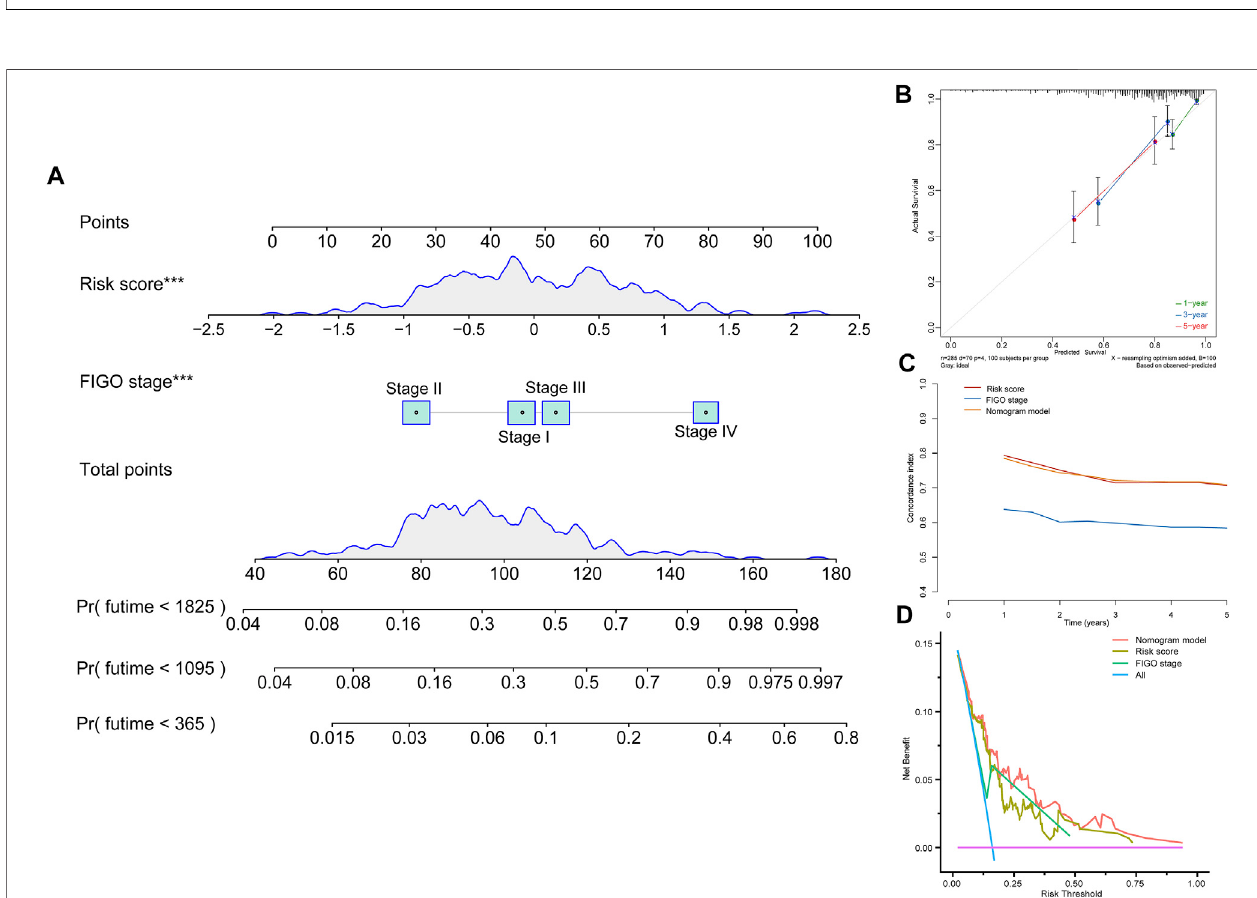
FIGURE 3 | Forest plot of the univariate and multivariate Cox regression analysis in TCGA and GSE44001 cohorts.